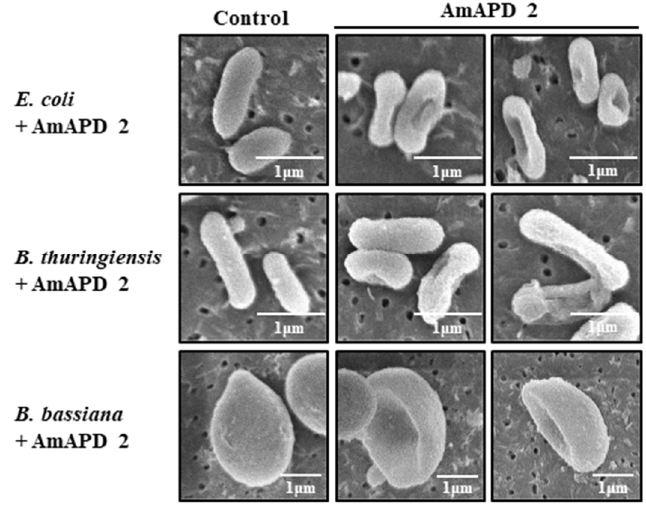
Figure 5. Scanning electron microscopy (SEM) observation of recombinant Apis mellifera apidermin 2 (AmAPD 2)-induced structural damage to microbial cell walls. The control column shows untreated E. coli , B. thuringiensis , or B. bassiana samples next to two AmAPD 2 columns showing treated microbial samples. Scale bars = 1 μ m. Table 1. Antimicrobial activity of recombinant Apis mellifera apidermin 2 (AmAPD 2) against bac- teria and fungi.